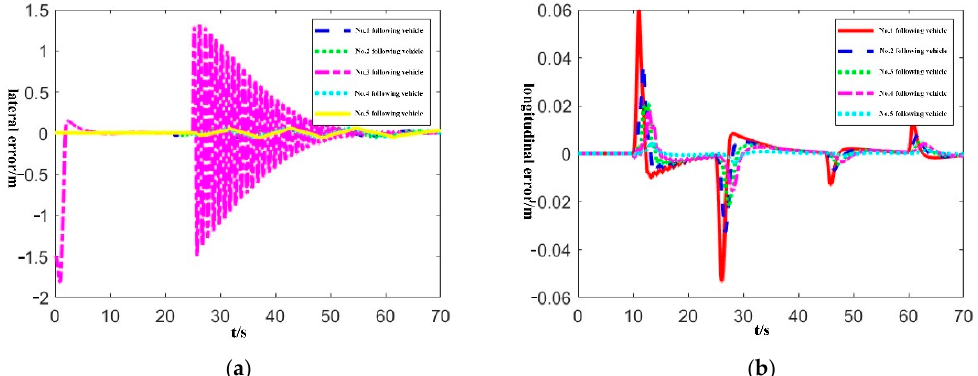
Figure 6. Lateral and longitudinal error curve in scenario 2. ( a ) Platoon lateral error; ( b ) Platoon longitudinal error